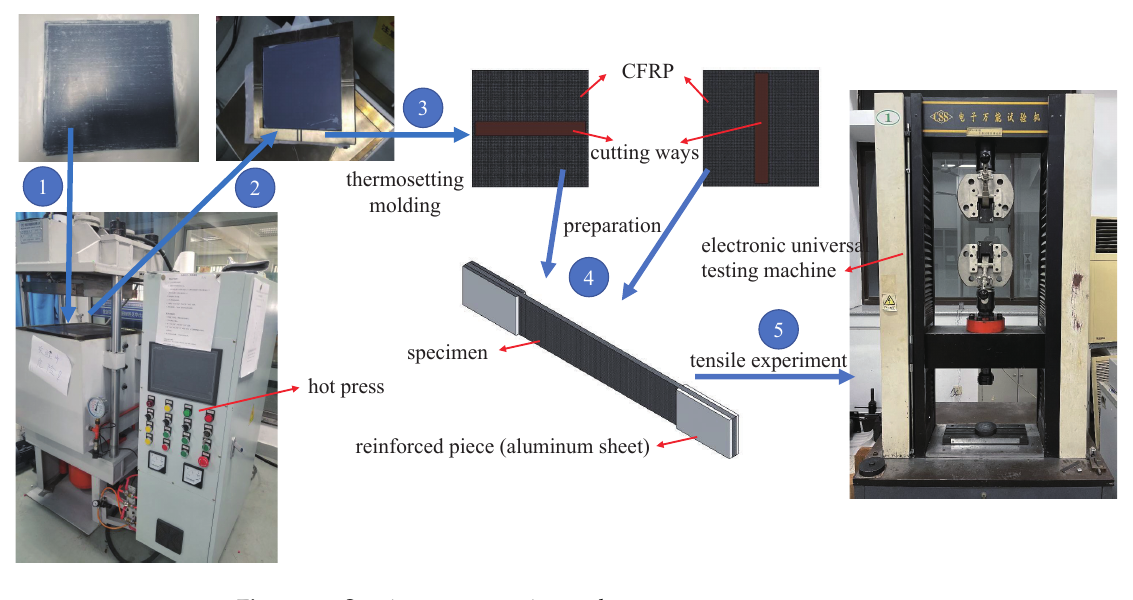
Figure 12. Specimen preparation and test